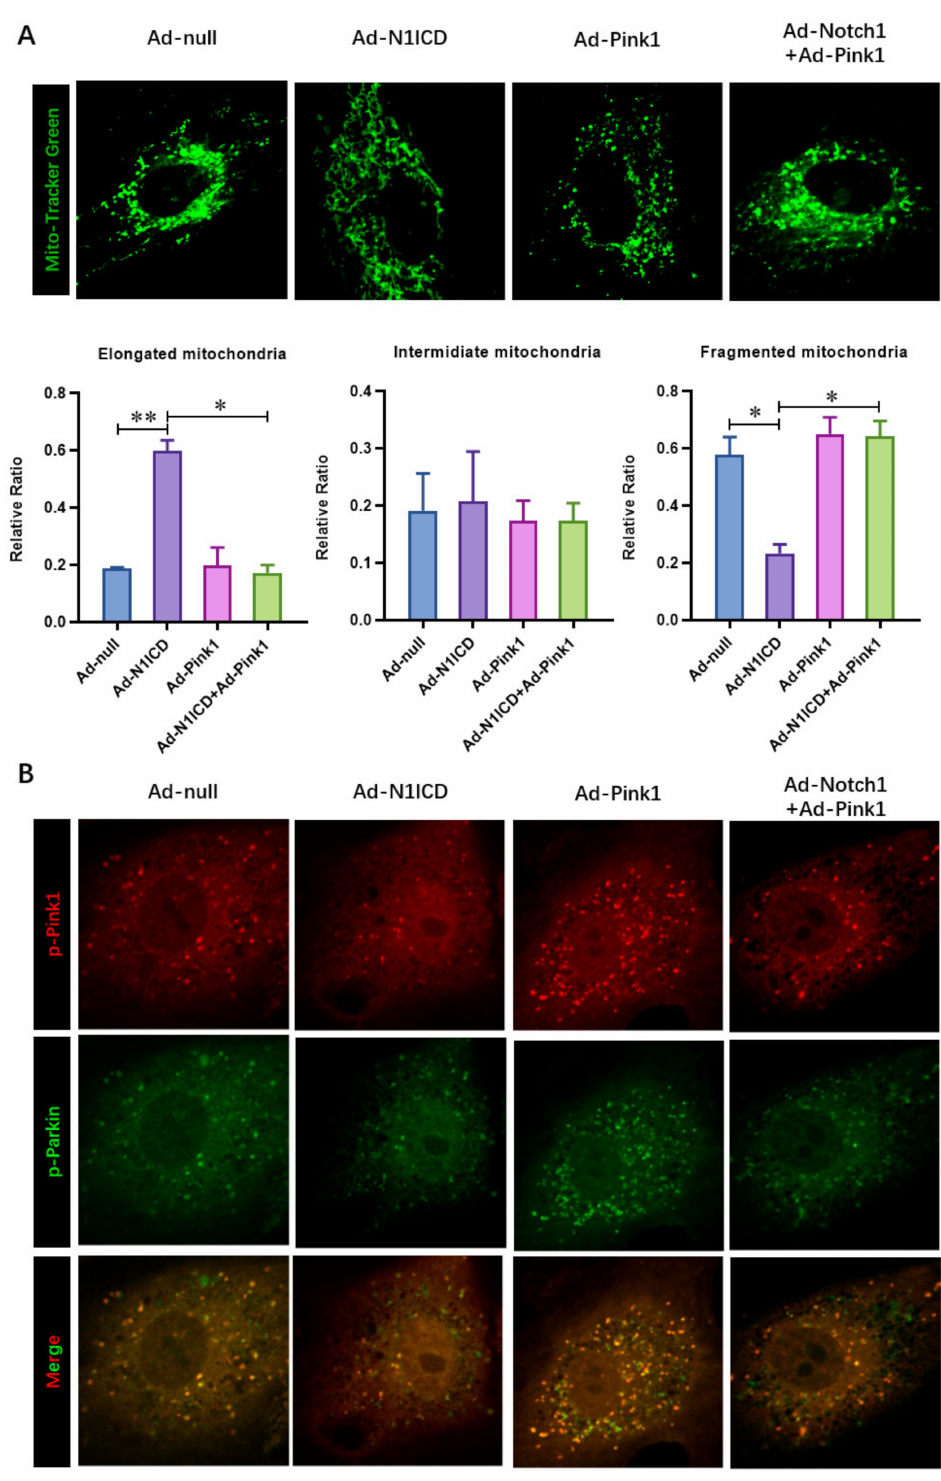
Figure 7. Pink1 over-expression impaired the protective effect of N1ICD against hypoxia/reoxygenation-induced mitochondrial fragmentation and mitophagy in neonatal cardiomyocytes. ( A ) Mito-tracker Green staining and confocal microscopy were used to observe the morphology of mitochondrial fragmentation in neonatal cardiomyocytes cells; ( B ) the mitophagy in cardiomyocytes was analyzed via the colocalization of GFP-LC3 puncta with Mito-TMRE-stained mitochondria as an index of mitophagy in neonatal cardiomyocytes cells; N = 3; * p < 0.05, ** p < 0.01 versus indicated